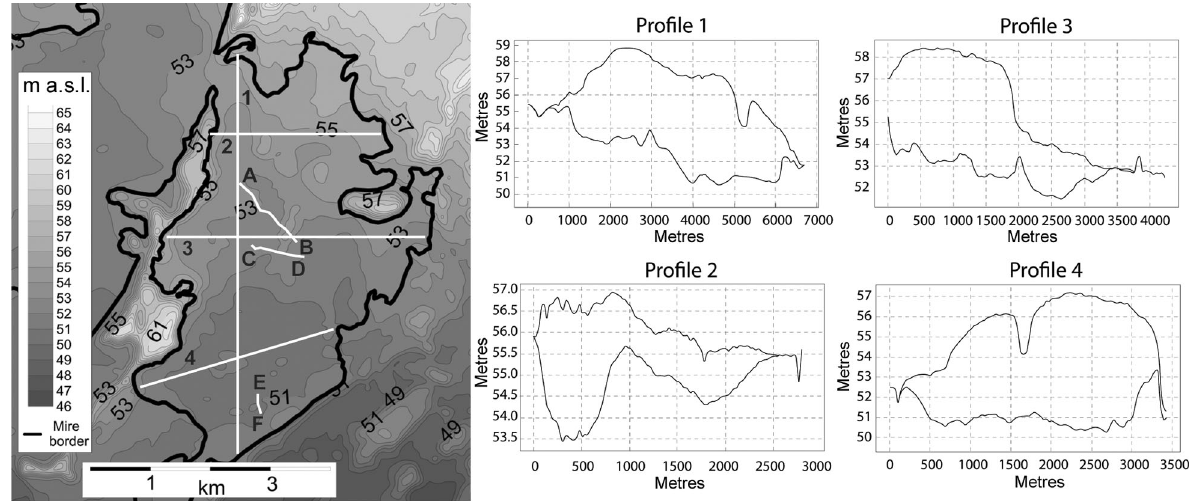
Fig. 6. The digital elevation model of the mineral surface under the Selisoo mire and location of the profiles displayed at the right side. AB, CD and EF refer to the location of GPR profiles in Fig. 4. The black line marks the mire